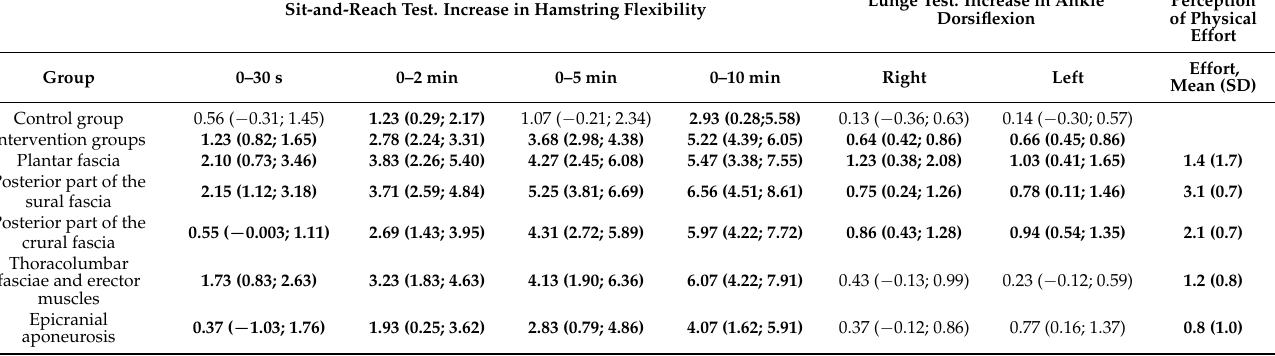
Table 2. Increase in hamstring flexibility (cm) for each time interval and increase in dorsiflexion of ankle for each group (mean (95%